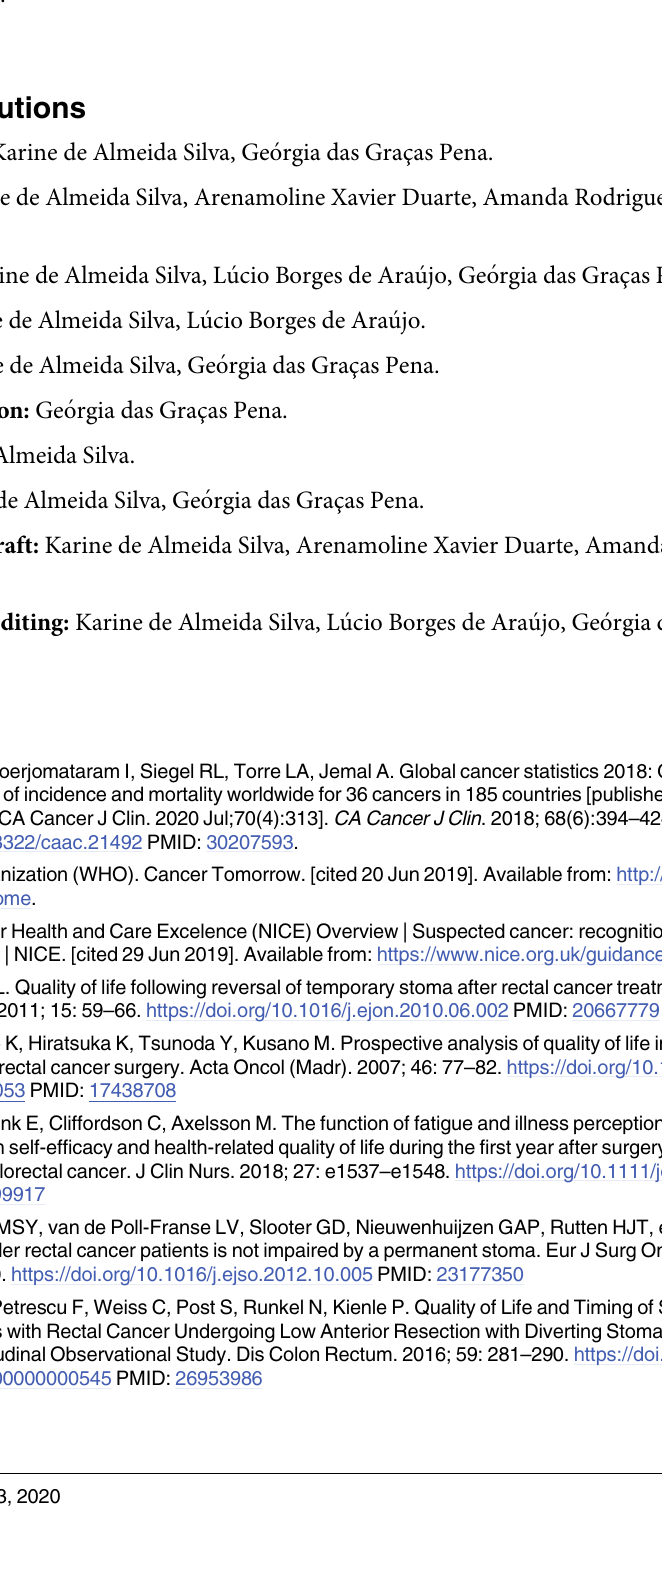
S2 Table. EORTC-QLQ-C30 and EORTC-QLQ-CR29 differences between patients who remained in the study and those lost to follow-up. � Mann-Whitney Test. S3 Table. EORTC-QLQ-C30 and EORTC-QLQ-CR29 differences between patients under- going curative and palliative surgery and patients with temporary and permanent